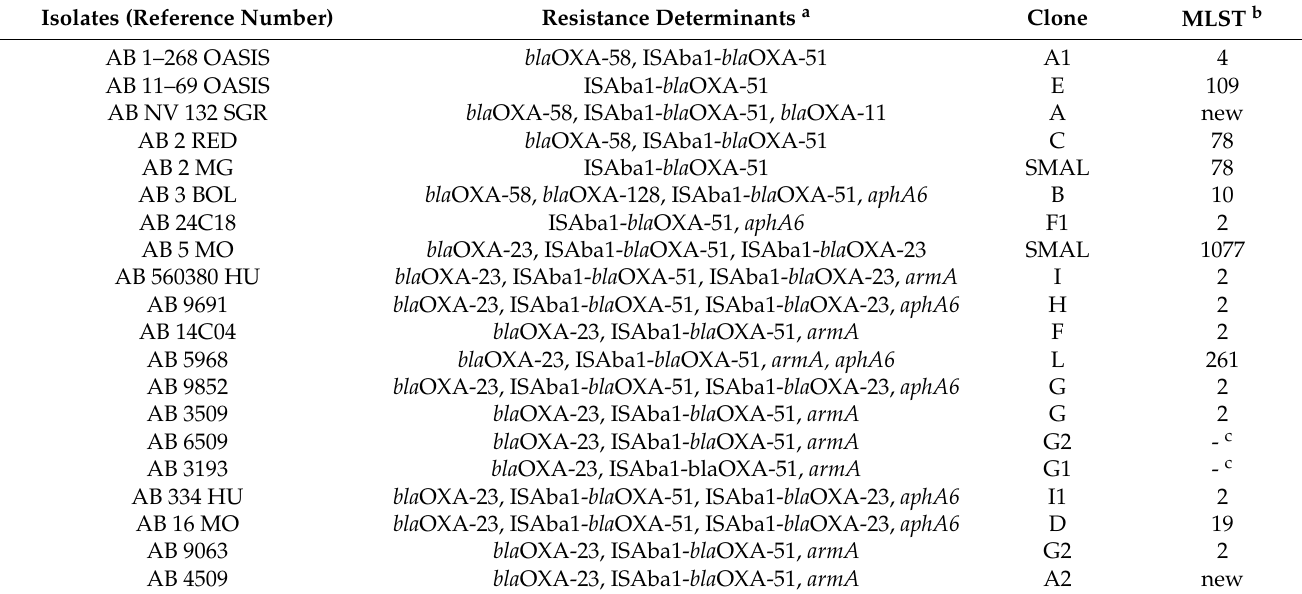
Table 2. Molecular characterization of Acinetobacter baumannii isolates.